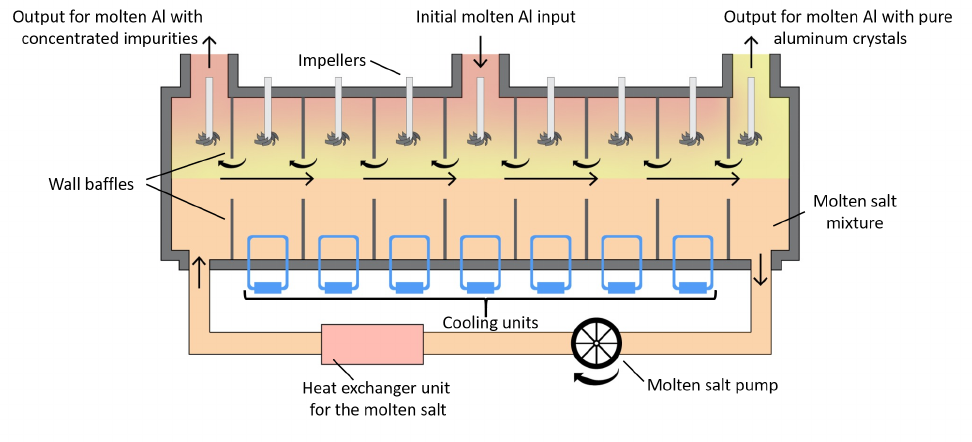
Figure 8. Sketch of the corus crystallizer technique—adapted from